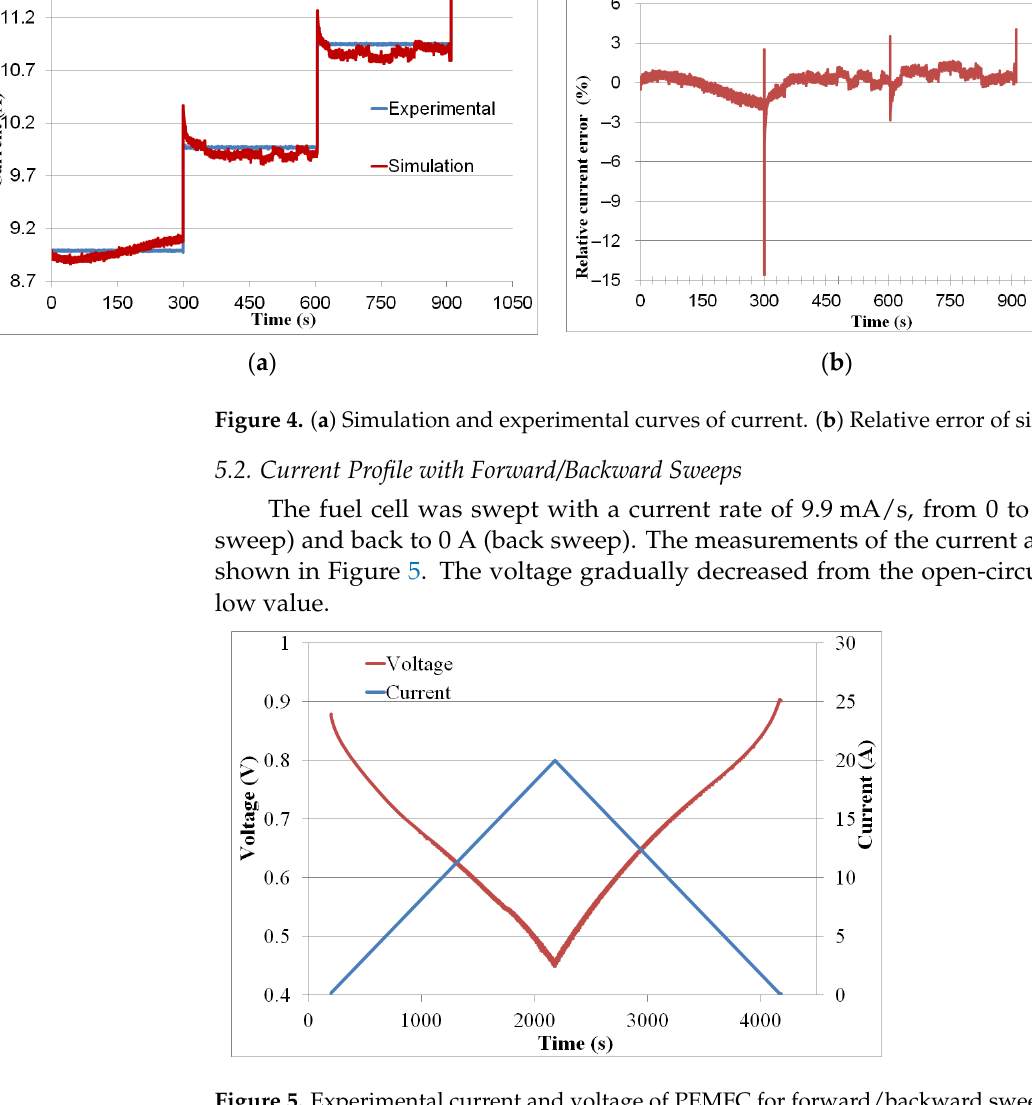
9 of 23 Figure 3. Experimental current and voltage of fuel cell.